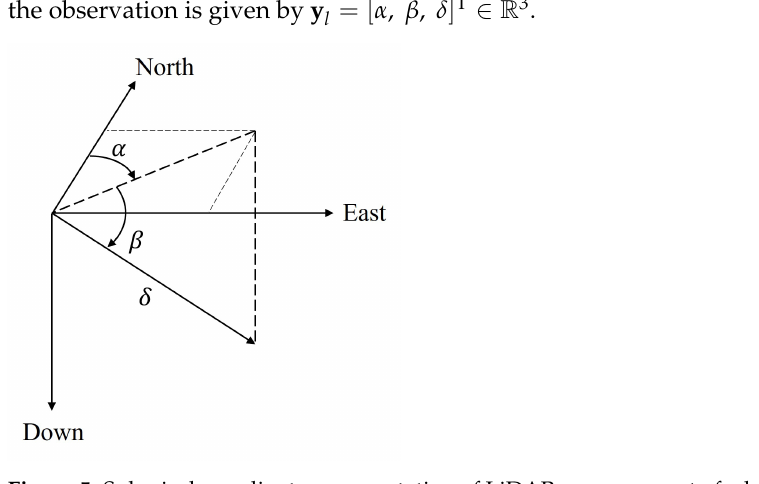
Figure 5. Spherical coordinate representation of LiDAR measurement of a